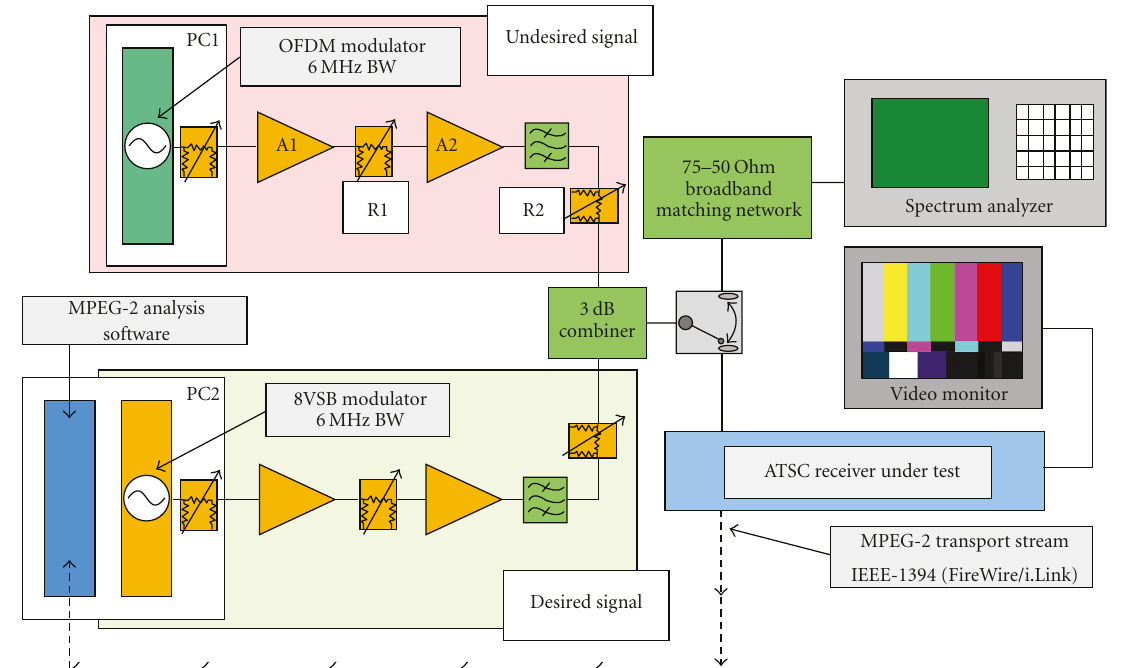
Figure 7: KU White Space Device Emulator and Testbed (KUWSDET) provides a controlled environment for observing the e ff ects of nonlinear